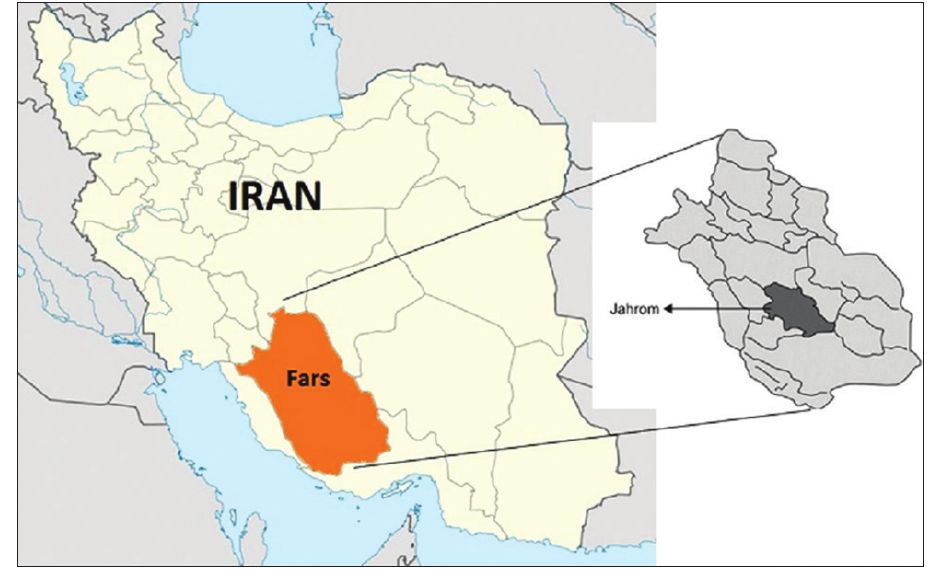
Figure-1: Geographical situation of the area of study, Jahrom, Fars,